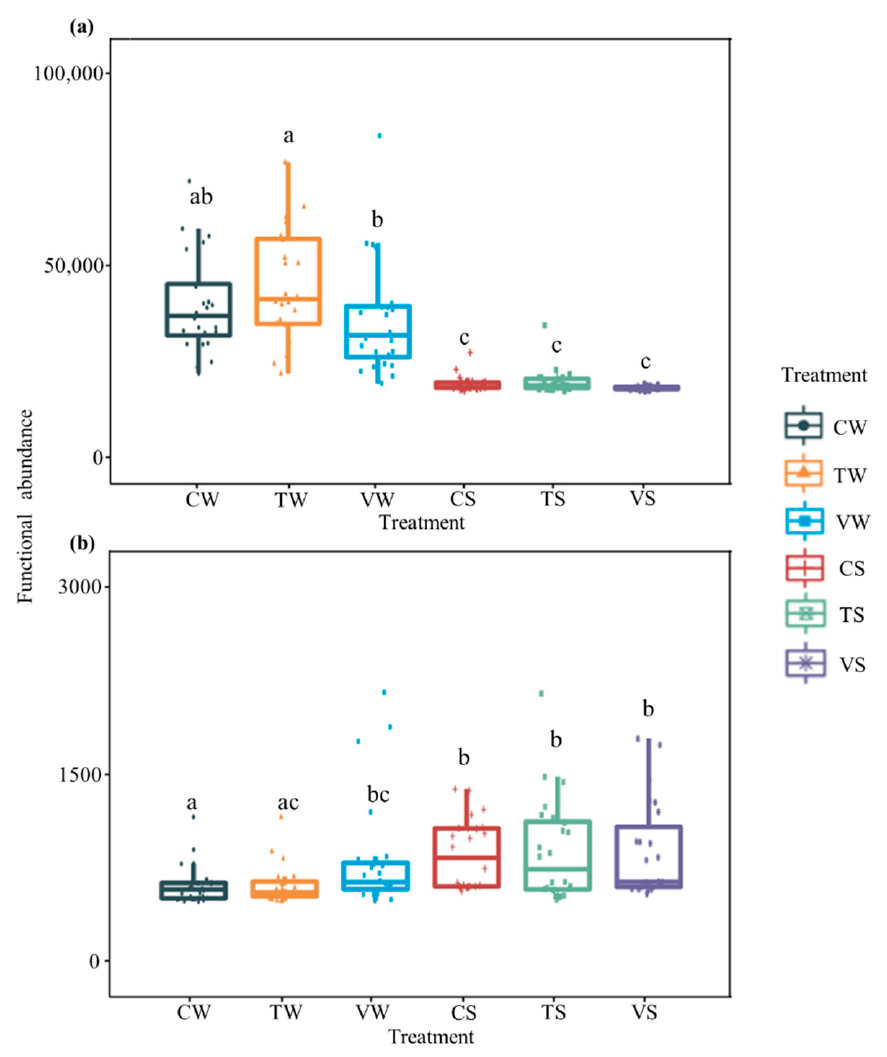
Figure 2. Metabolic function total abundance of bacteria related to the carbon ( a ) and nitrogen ( b ) cycle under different treatments in water and sediment. C, ambient temperature; T, +4 ◦ C constant warming; V, variable warming; W, water; S, sediment. All data are presented as the mean ± SE. The letters above the bars represent significant differences between treatments ( p <